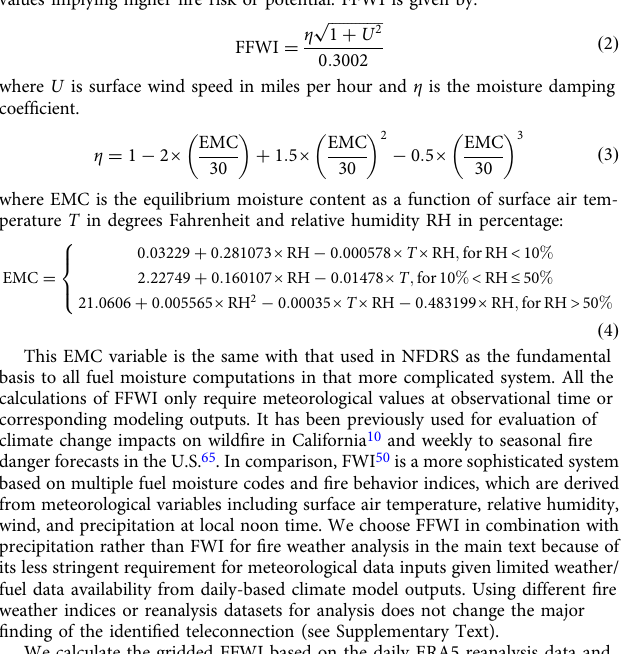
Statistical analysis and signi fi cance tests . We fi rst calculate the correlation coef fi cients between the time series of the regional and seasonal average FFWI (as shown in the red line in Fig. 1b) and the seasonal average Arctic sea-ice con- centrations at each grid cell to identify the most sensitive Arctic regions affecting regional fi re weather conditions over the western U.S. These SIC-FFWI correlations are shown by the color shading over the Arctic region in Fig. 1a, suggesting the Paci fi c sector of the Arctic (outlined by the red box over the Arctic in Fig. 1a) as the most critical region of interest. Then the Arctic SIC over this region is averaged to obtain its time series (as shown in the blue line in Fig. 1b) for calculating corre- lation with the regional average FFWI time series. The correlation coef fi cient between these two time series is − 0.68 with p -value < 0.01, recon fi rming the close ffiffiffiffiffiffiffiffiffiffiffiffiffiffi p connection between the two regions in terms of temporal variations of the two η 1 þ U 2 variables. To exclude the impact of long-term trends in both time series, we also ð 2 Þ FFWI ¼ conduct the same analysis based on the detrended time series in Supplementary 0 : 3002 Fig. 1. The correlation coef fi cient between the detrended data is lower but still statistically signi fi cant ( r = − 0.50; p -value< 0.01), suggesting a robust relationship on both interdecadal and interannual time scales. We then conduct composite analyses based on original or detrended observational and reanalysis data to identify regional weather and fi re activity responses to the Arctic sea-ice changes on different time scales. The members in each composite group are selected based on the regional averaged and normalized SIC time series before (Fig. 1b) and after detrending (Supplementary Fig. 1b). We use ±1 standard deviations of the original (detrended) SIC time series as thresholds for selecting members in SIC − /SIC + (SICnotrd − /SICnotrd + ) groups in Fig. 1 (Supplementary Fig. 1). Please note that the MTBS burned area in Supplementary Fig. 1c and meteorological variables such as Z500 and FFWI in Supplementary Fig. 1a, b and air temperature, zonal winds, precipitation, and relative humidity in Fig. 3b, e, h, k are also detrended to keep consistent with the detrended SIC time series in SICnotrd − /SICnotrd + groups. The long-term trends in time series are removed using the NCL dtrend function, while the trends in gridded data are removed by fi rst estimating long-term trends in zonal mean values and then subtracting these trends from gridded values at same latitudes to retain heterogeneity in the zonal direction after removing global warming effects and their footprint in the meridional direction such as AA. In this way, the strong global warming effect is largely removed in the detrended data as shown in Fig. 3b, k. We use a two-sided Student ’ s t -test to test the statistical signi fi cance of the differences between two groups of time averaged data (either for each grid cell or for regional averages) such as the seasonal/monthly FFWI composites in Fig. 1a, c ( n = 6), model-simulated seasonal total burned area composites in Fig. 2a ( n = 40), model-simulated regional average atmospheric and fi re indices in Fig. 2b-e ( n = 40), and seasonal mean fi re weather variables in Fig. 3 ( n = 6 for reanalysis- based data and n = 40 for model-based data). These data generally satisfy the assumptions of the t -test including normality and randomness of samples. If a p - value obtained from the t -test is no larger than a threshold, e.g., α ¼ 0.01, 0.05, or 0.1, then we reject the null hypothesis of equal averages in the sample groups at certain signi fi cance levels corresponding to the threshold. We also use a stricter control of False Discovery Rate (FDR) method 69 to protecting against overstatement of multiple-testing results due to the in fl uence of possible spatial correlation in Figs. 1a and 2a. Local null hypotheses of each grid cell are rejected